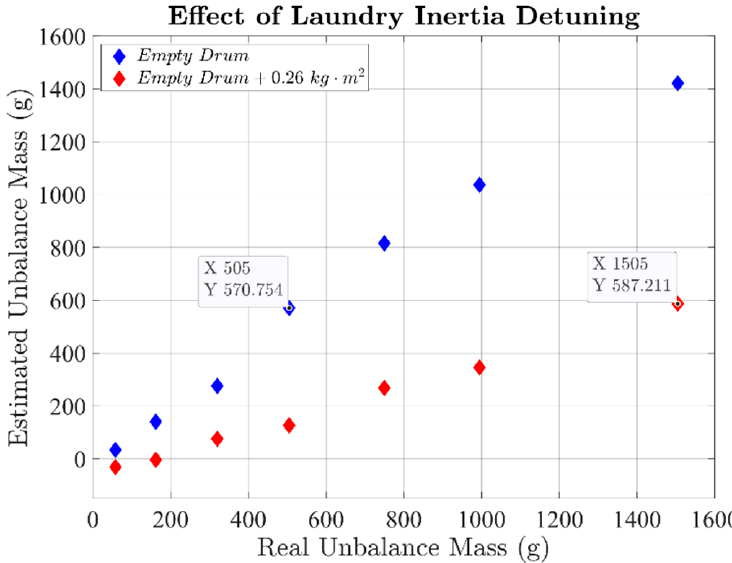
Figure 7. Conventional method: effect of the laundry inertia detuning on the unbalance mass estimation.